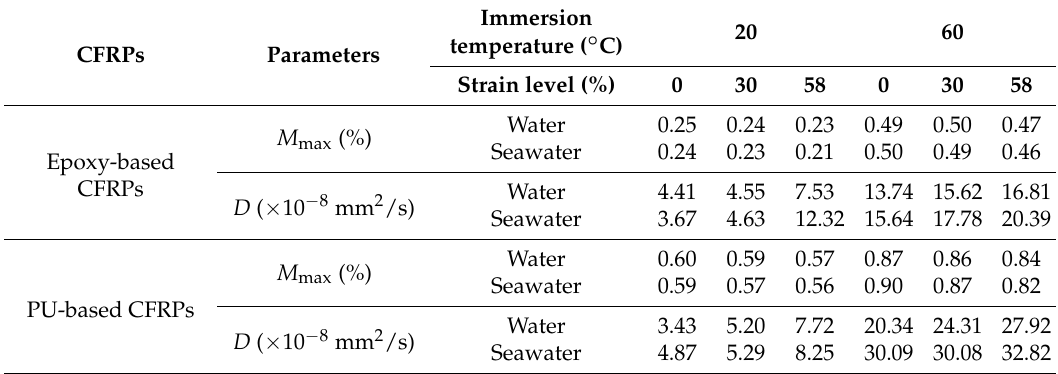
Table 2. Water diffusion parameters of epoxy- and PU-based CFRPs in water or seawater, respectively.